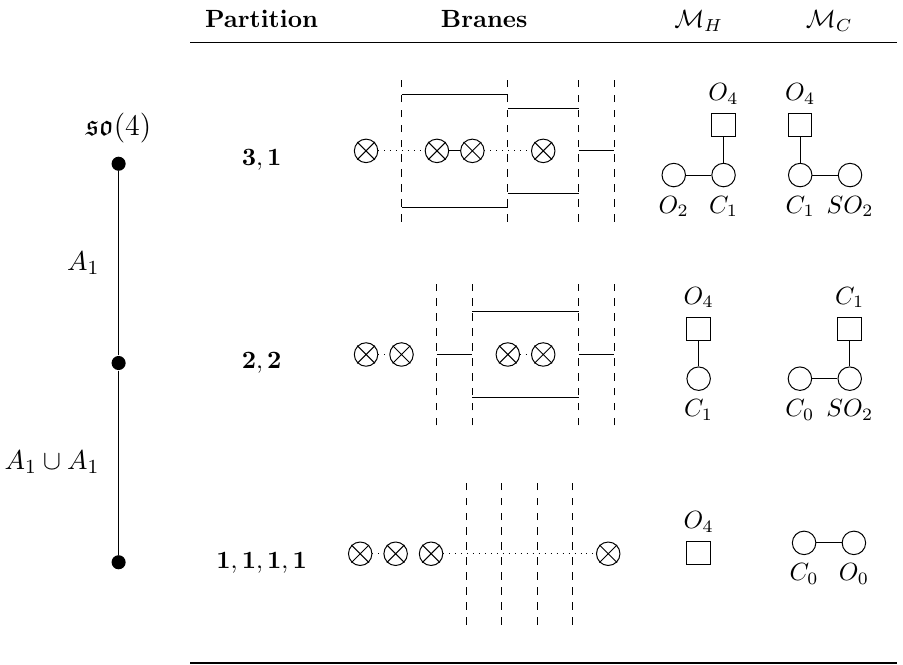
Table 3. Summary of Kraft-Procesi transitions for the nilpotent orbits of so (4). The brane systems in the middle depict models whose Higgs branch is the closure of the nilpotent orbit labelled by each Partition . The column M H contains the quivers of such models, with M H = (cid:22) O (cid:21) . The column M C depicts the quivers of the models obtained after performing S-duality transformation on the brane systems, they have M C = (cid:22) O (cid:21) . The C 0 and O 0 gauge nodes have been left in this column to highlight the e(cid:11)ect that the transition has on these quivers: the (cid:13)avor nodes move along a (cid:12)xed structure of gauge nodes, while the rank of the gauge nodes decreases.